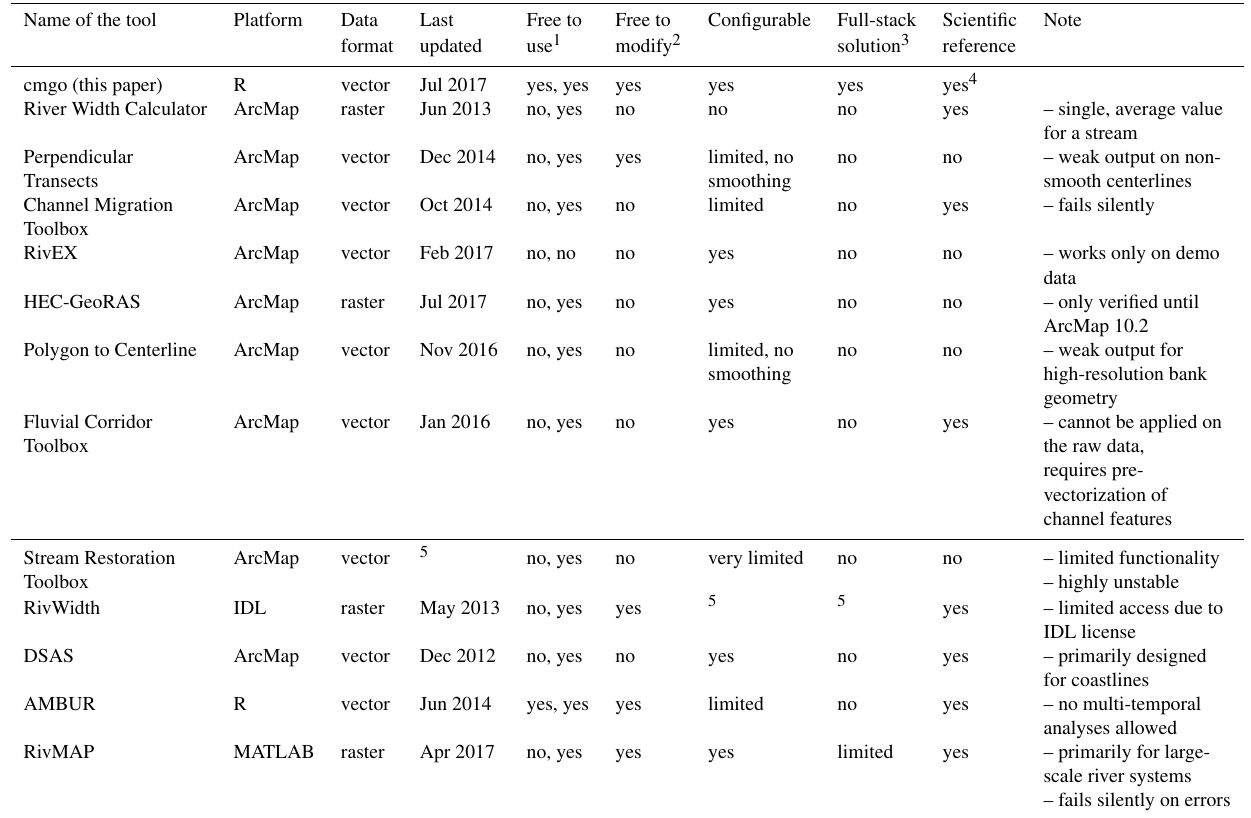
Table 1. Overview of existing products; 1 the two values indicate free use of framework (first) and plugin (second value). 2 A product is considered free to modify if users can access and edit the source code and a license explicitly allows users to do so. 3 A product is considered a full-stack solution if it performs all steps from the bank geometry to the derived channel metrics. 4 This publication. 5 No information could be